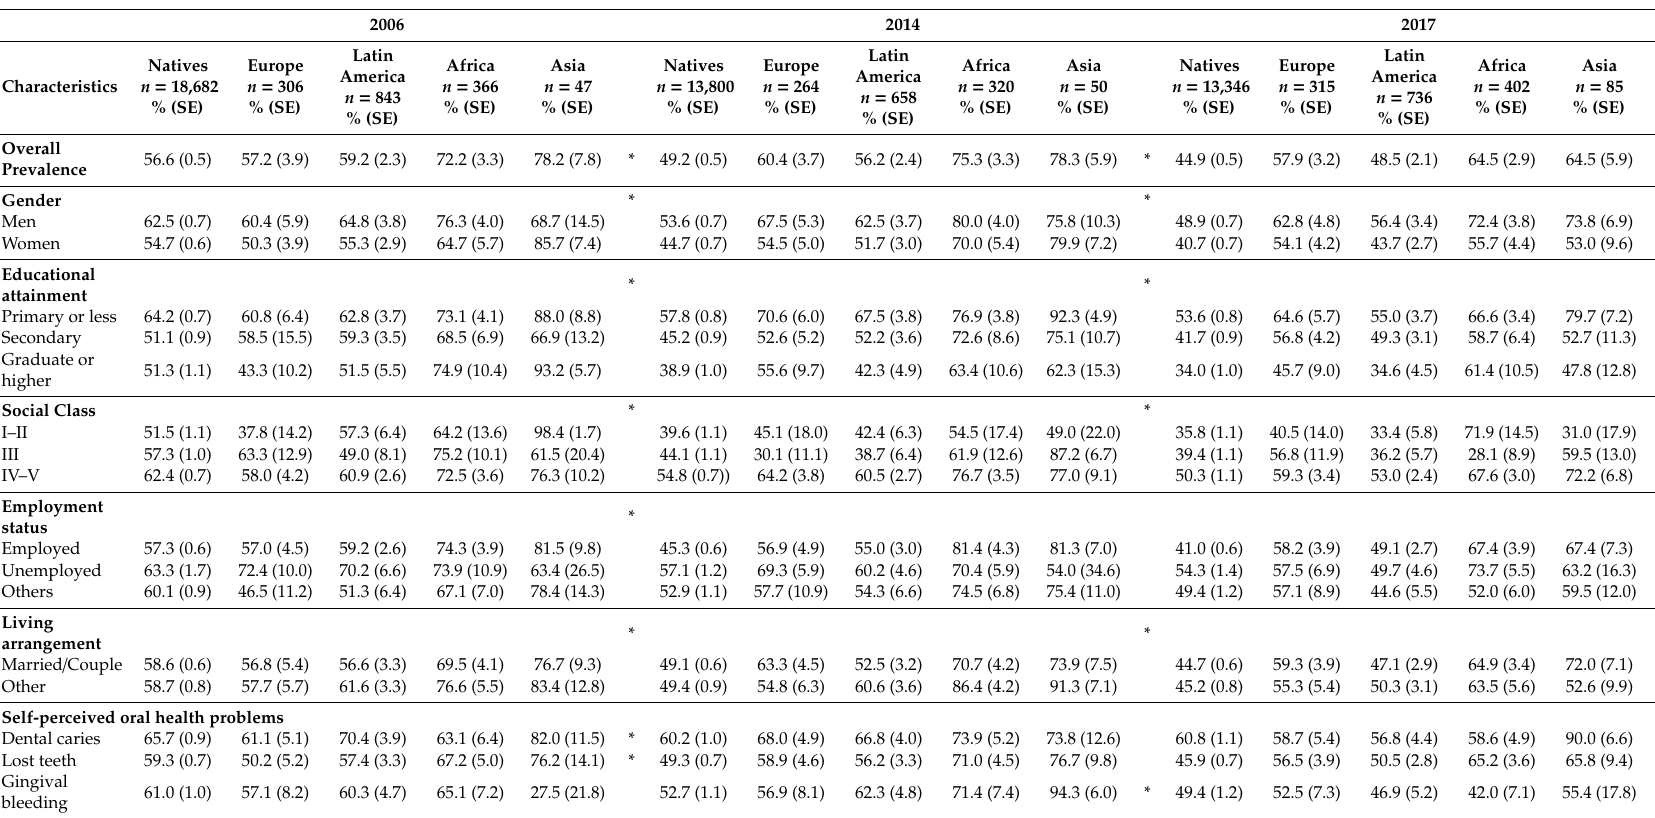
Table 2. Prevalence estimates for non-use of dental care in the last year according to place of birth by year of the survey: Spanish National Health Survey 2006 and 2017 and European Health Survey in Spain